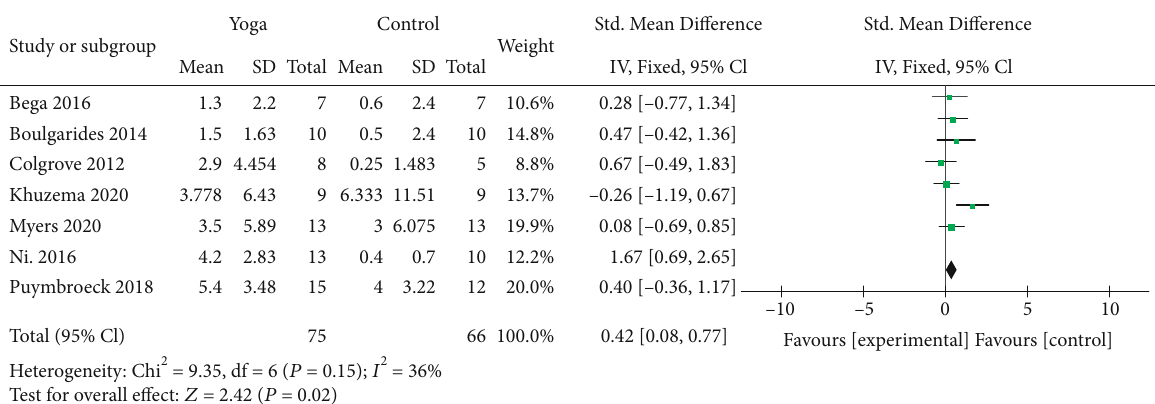
Figure 5: Forest plot from the meta-analysis of yoga on balance